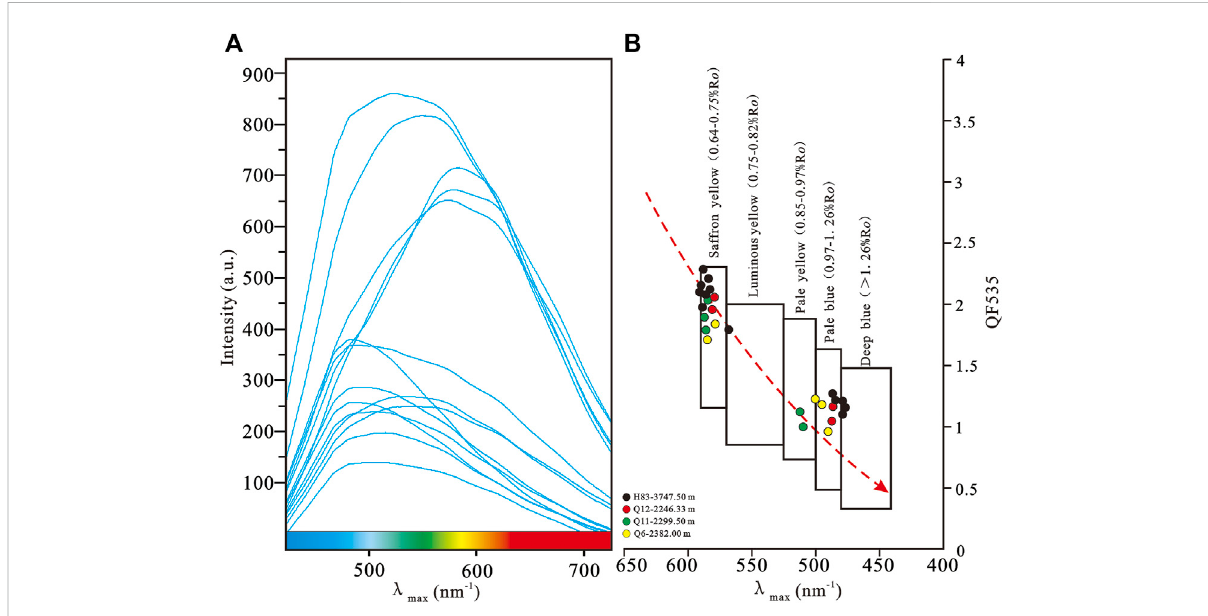
FIGURE 9 Micro fl uorescence spectra of liquid hydrocarbon inclusions (A) and λ max (wavelength of the maximum intensity) versus QF 535 (ratio of the 535 – 750 nm fl ux to the 430 – 535 fl ux) diagram (B)